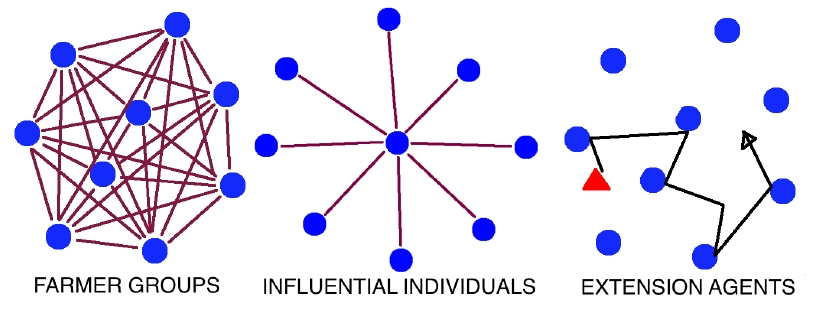
Figure 2. Farmer